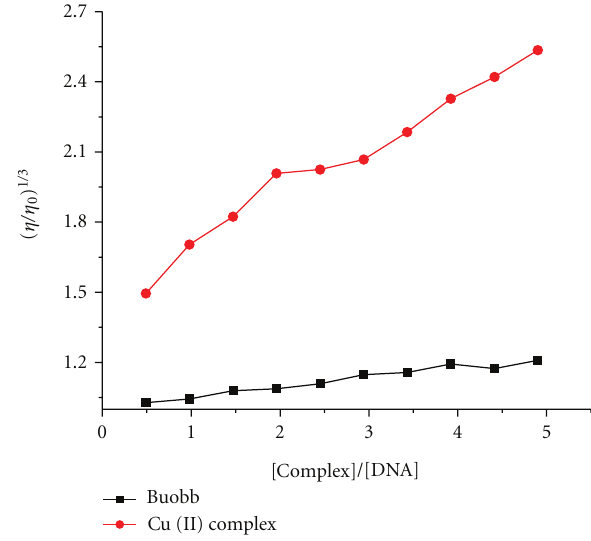
Figure 6: E ff ect of increasing amounts of the compounds on the relative viscosity at 25.0 ± 0.1 ◦